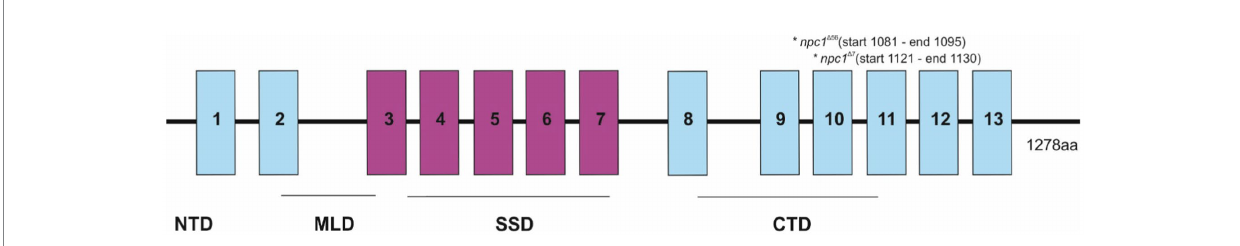
FIGURE 1 Representation of the npc1 mutations in the NPC1 protein. 1–13 transmembrane domains were represented and also NTD (N-terminal domain), MLD (Middle luminal domain), SSD (sterol-sensing domain), and CTD (C-terminal